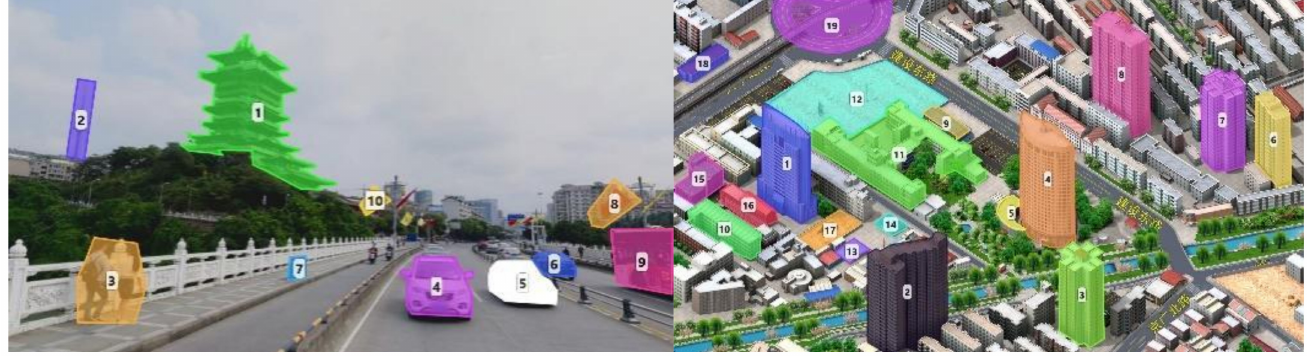
Figure 2. An example of AOI